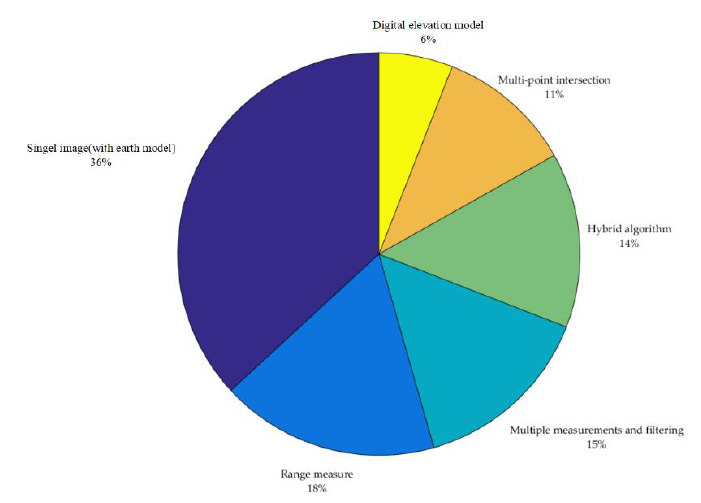
Figure 2. Distribution of positioning foundation model.